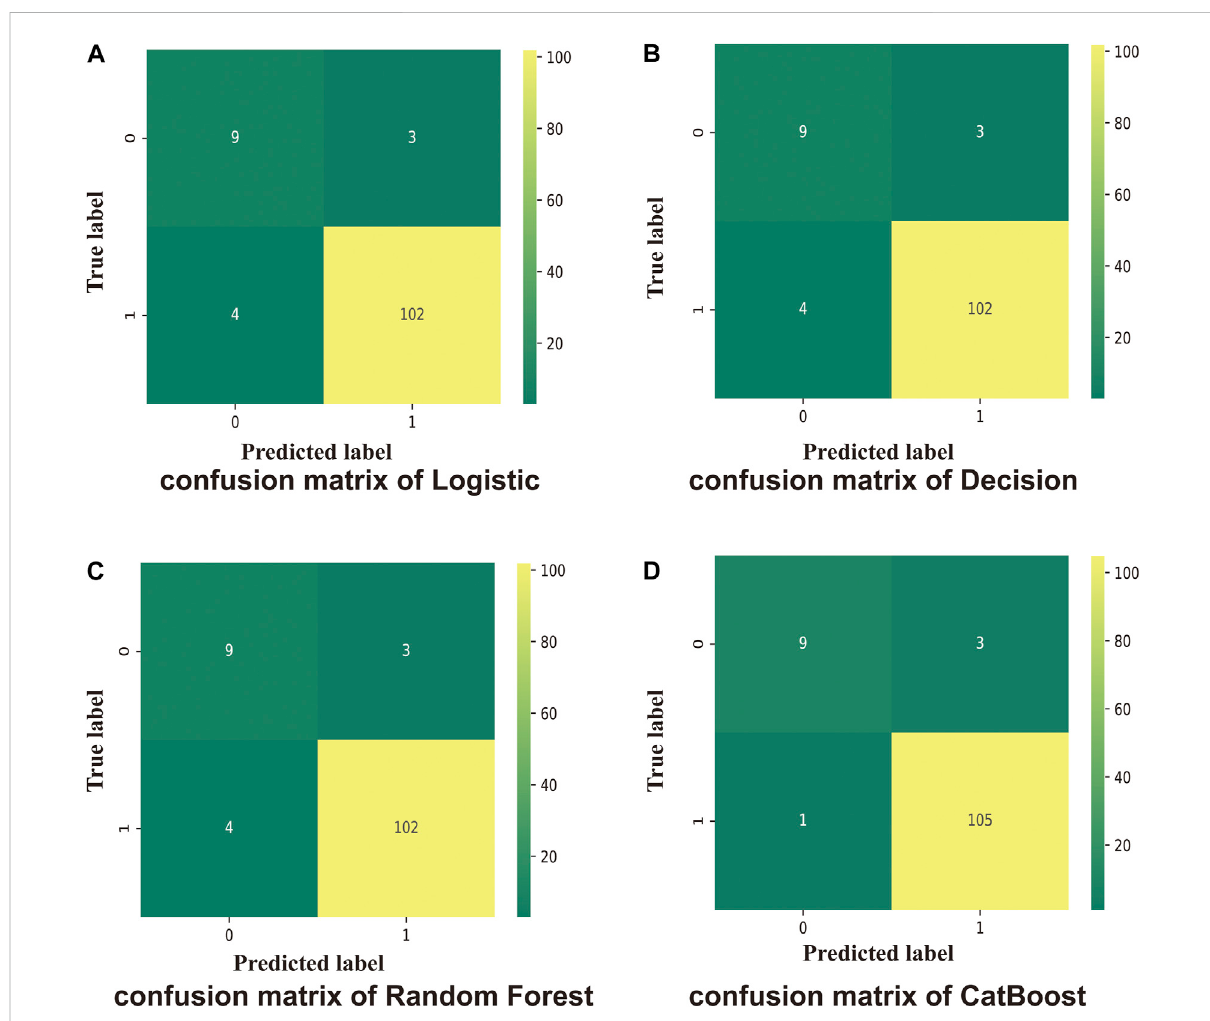
FIGURE 2 Confusion matrix. One indicates sepsis; 0 indicates healthy. Numbers are the total number of patients. (A) Test scores for the logistic method (0.94); 0.72 (f1-score of healthy patients), and 0.97 (f1-score of patients with sepsis). (B) Test score using the Decision Tree method (0.95); 0.72 (f1- score of healthy patients), and 0.97 (f1-score of sepsis patients). (C) Test score using the Random Forest method (0.96); 0.72 (f1-score of healthy patients), and 0.97 (f1-score of sepsis patients). (D) Test score using the CatBoost method (0.97); f1-score of healthy: 0.82, f1-score of sepsis: